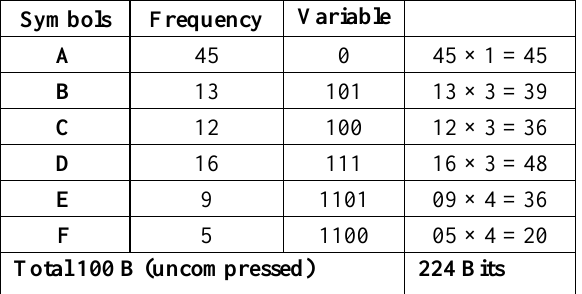
Table 2. Variable length codes - dynamic Huffman